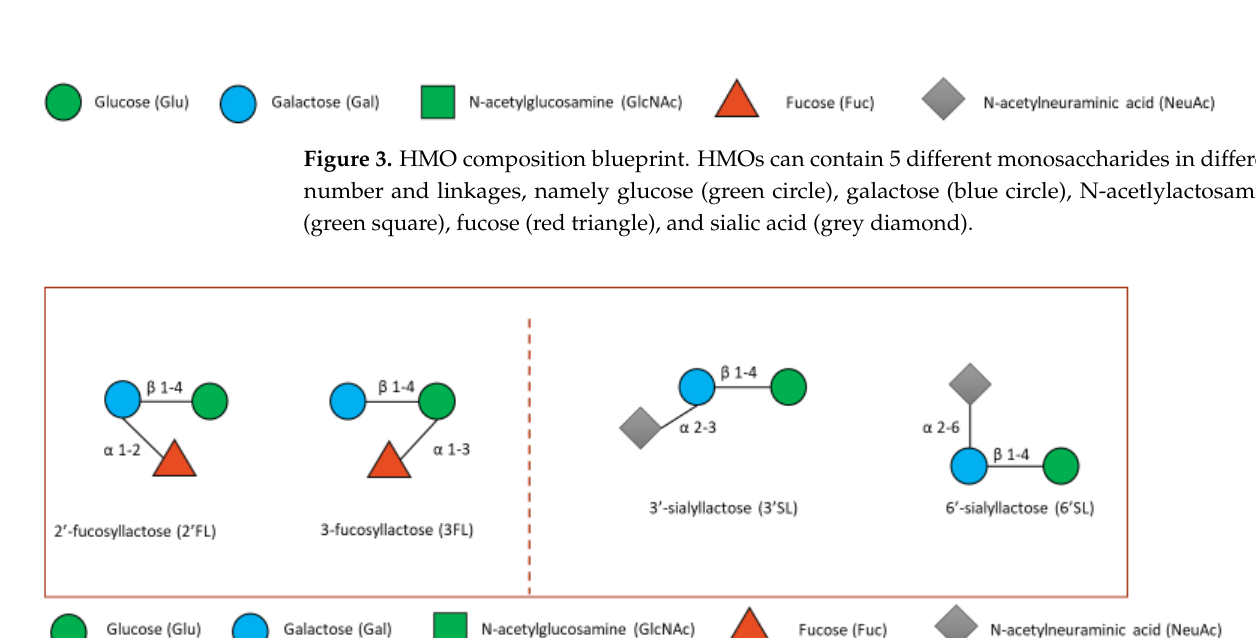
Figure 3. HMO composition blueprint. HMOs can contain 5 different monosaccharides in different number and linkages, namely glucose (green circle), galactose (blue circle), N-acetlylactosamine (green square), fucose (red triangle), and sialic acid (grey diamond).